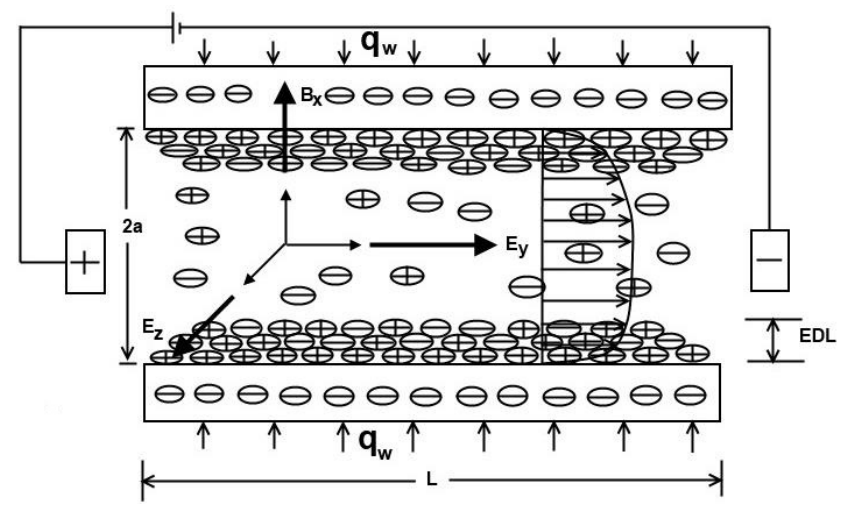
Figure 5. Schematic diagram of a rectangular microchannel showing EDL with coordinate system taken to establish the present study.